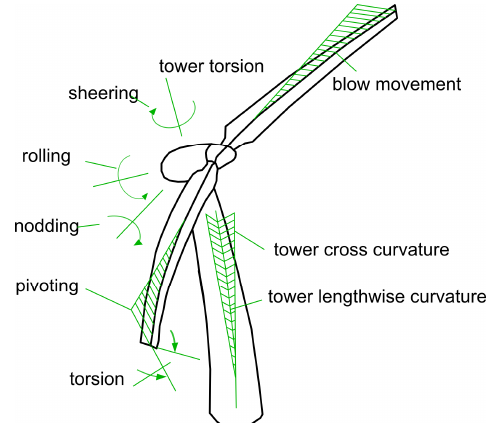
Figure 2. Degrees of freedom of the WEC (after Hau 2008)